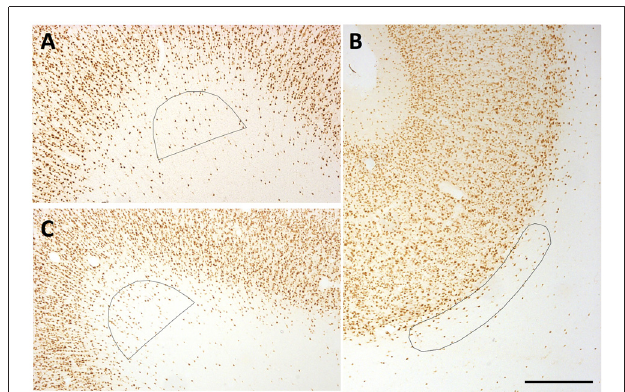
FIGURE 2 | Representative counting frames (0.21 mm 2 ). (A,C) Semi-circles delineate counting zones at SFG (A) and temporal region (TE) (C) gryal crowns. (B) Ovoid outline delineates counting zone for a Par sulcal region. Scale bar = 500 µ m.